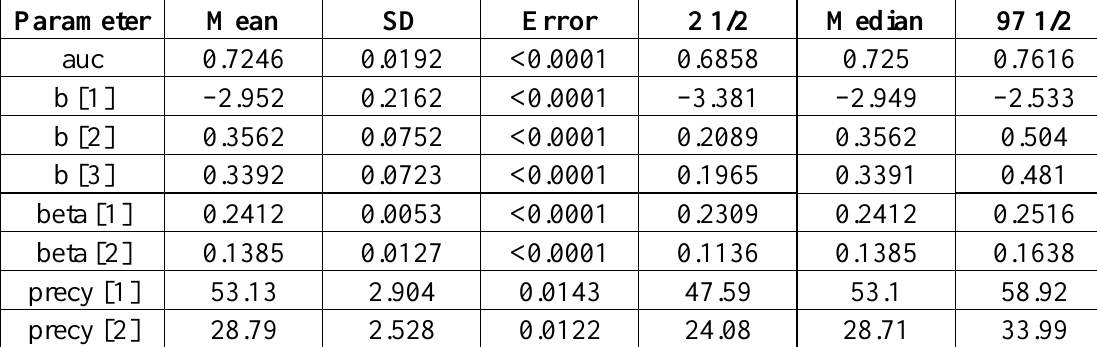
Table 29. Posterior accuracy of the combined